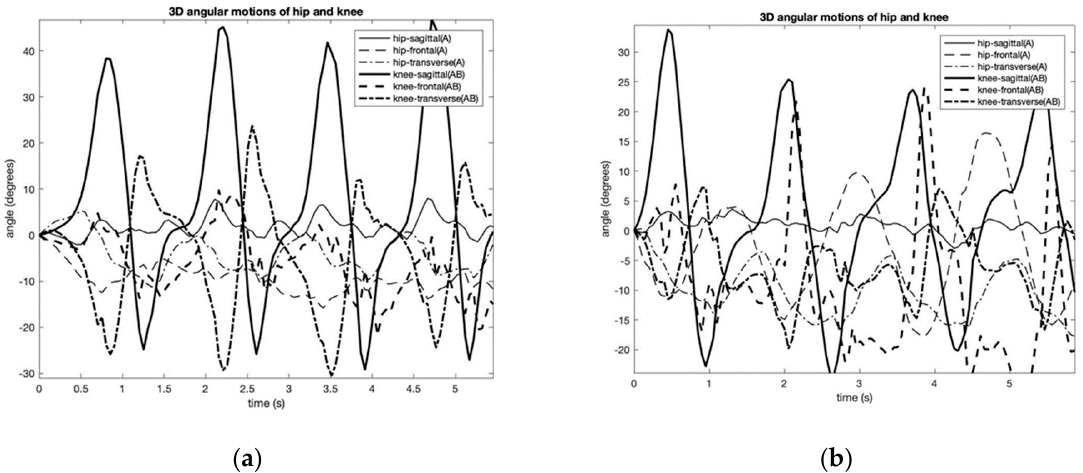
Figure 5. An example of calculated 3-D hip and knee joint angle patterns associated with normal ( a ) (periods of 1.3 s) and simulated hemiplegic walking ( b ) (periods of 1.8 s).